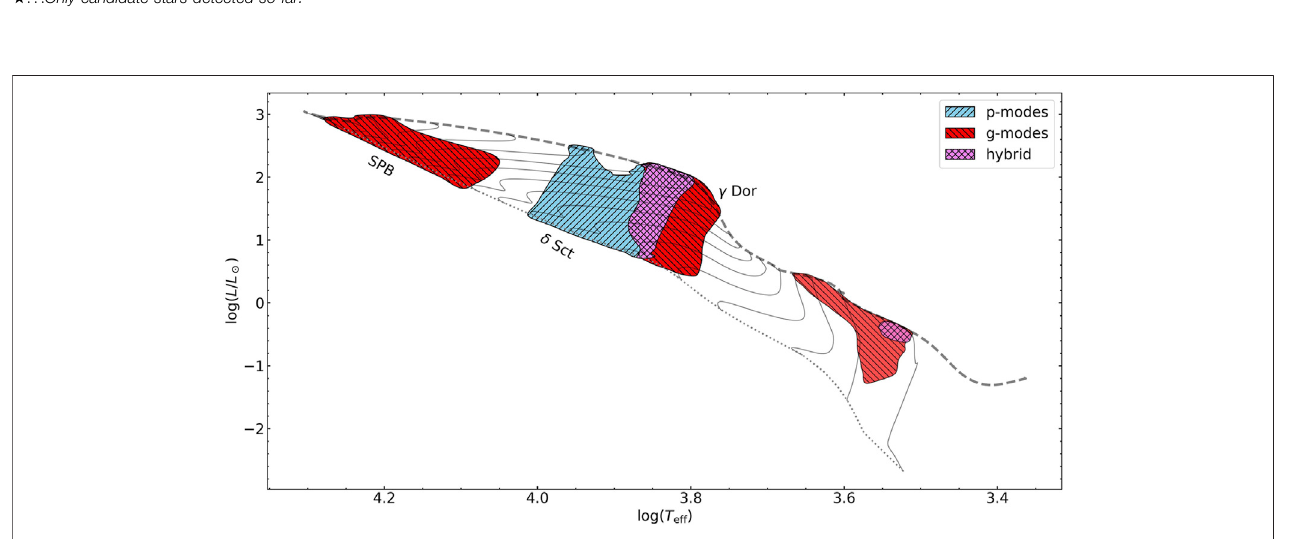
Frontiers in Astronomy and Space Sciences |